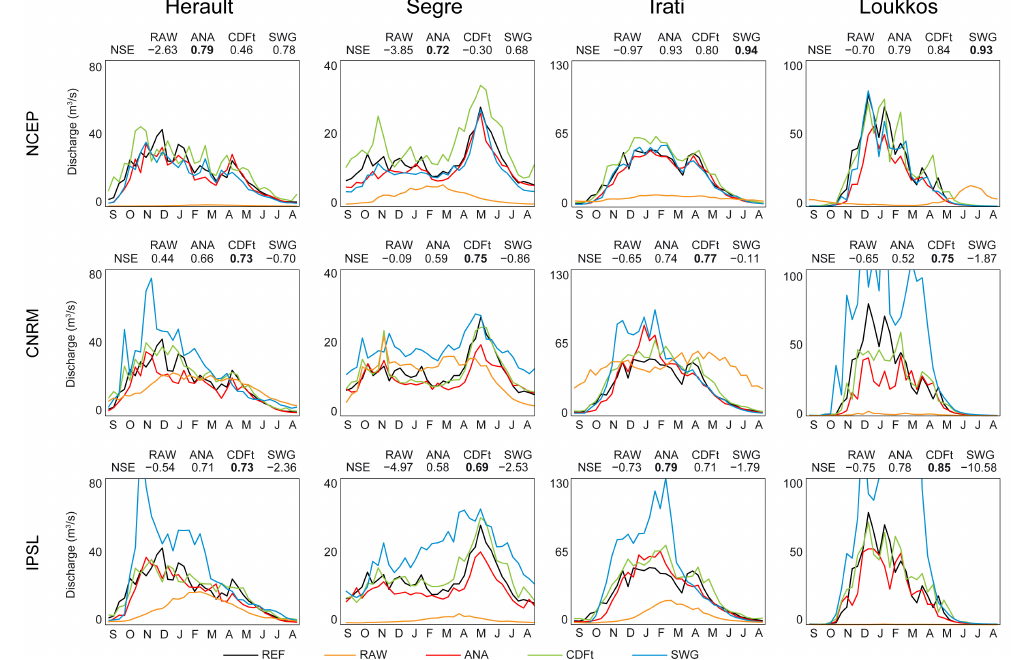
Figure 8. Comparison of seasonal variations in streamflow simulated using REF data, RAW (NCEP or GCM) data, and the three downscaling methods (applied to NCEP, CNRM and IPSL) for each basin. The NSE values for the mean 10-day discharge between REF and the simulation concerned are given above each panel. The best values are in bold.